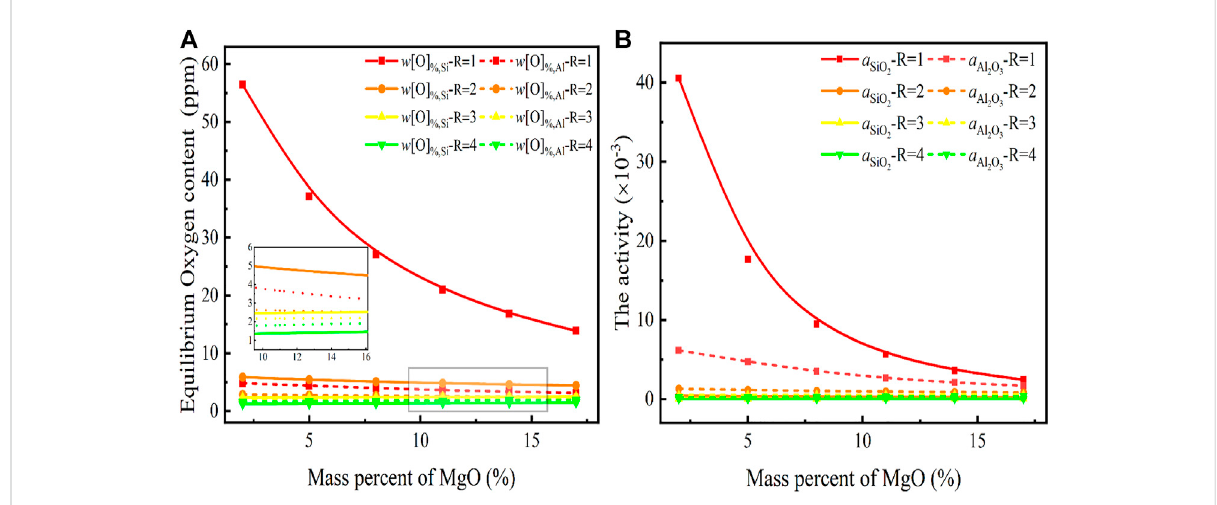
FIGURE 1 Relationship between basicity and MgO content in CaF 2 -CaO-Al 2 O 3 -MgO-SiO 2 slag for (A) equilibrium oxygen content, (B) a SiO 1,873 K for a certain steel composition { w [Si] % = 5.0, w [Al] % = 0.1}.